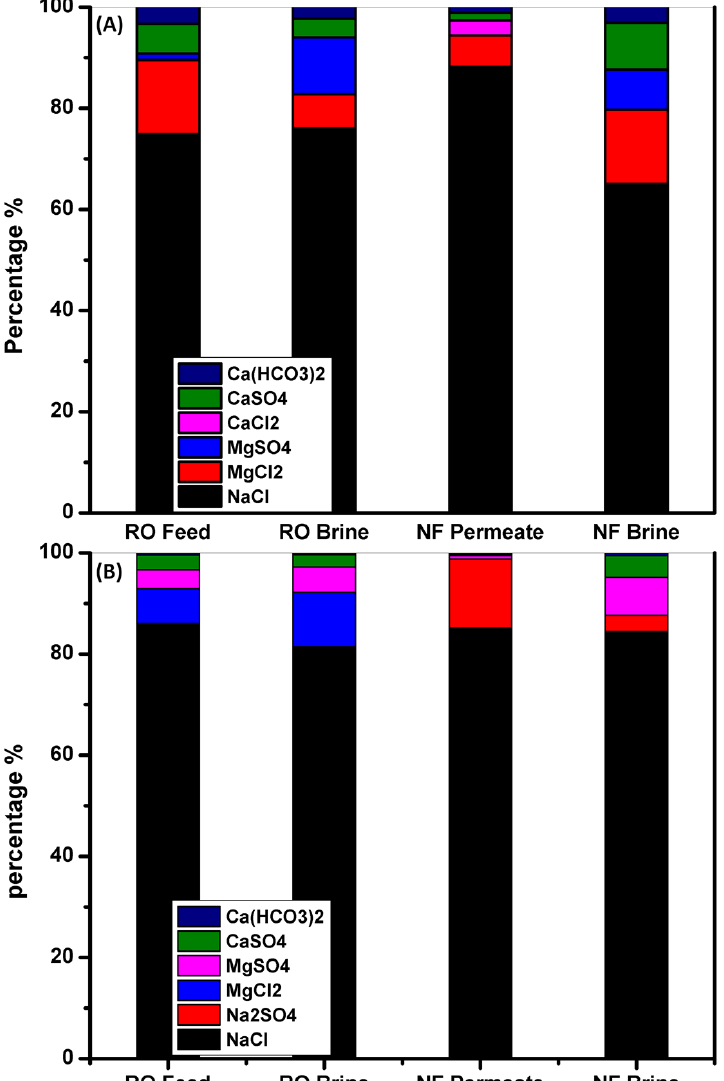
Figure 4. Bar graph representing the hypothetical ions combination (electrolyte) of the feed, RO-brine, NF permeate, and NF brine of ( A ) BW and ( B ) SW samples. Operating conditions: pressure 0.7 MPa, operation time 8 h, operation temperature, 25 °C & flow rate, 5 L/min.